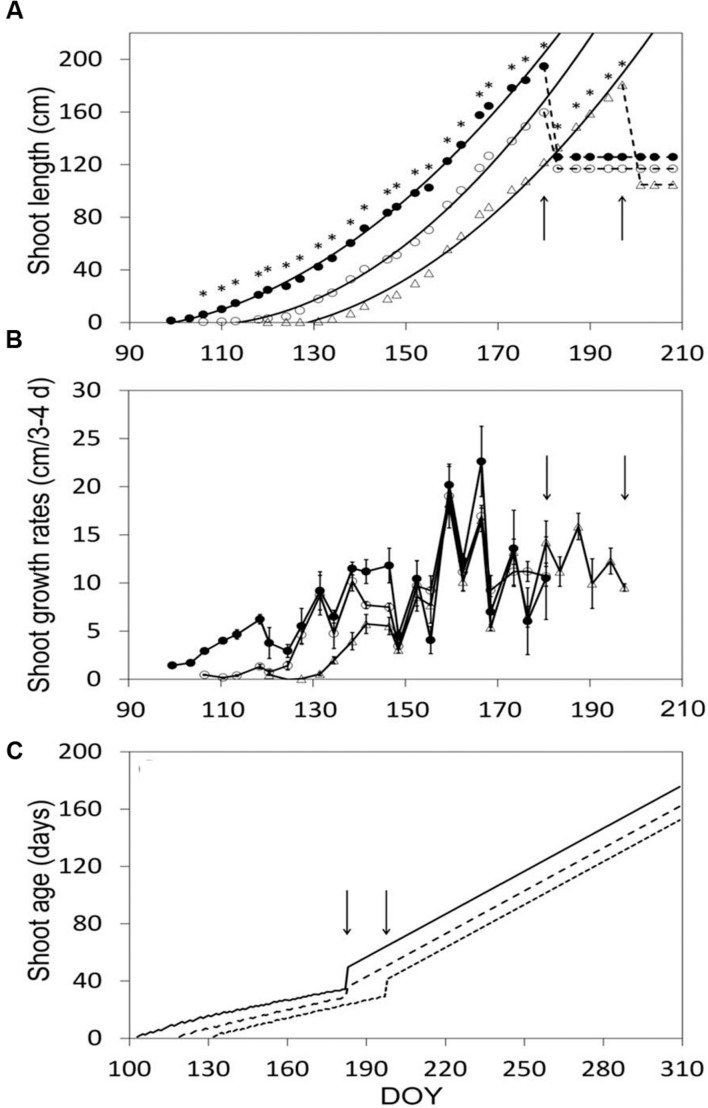
Shoot elongation (cm, A), shoot growth rates (cm/3–4 days, B) and seasonal mean shoot age (days, C) as affected by winter pruning treatments. In (A) exponential equations fit to shoot elongation vs. DOY data were: y = 0.0229x2 – 3.8597x + 157.29 (R2 = 0.996), y = 0.0301x2 – 6.292x + 326.88 (R2 = 0.995) and y = 0.026x2 – 5.6918x + 302.21 (R2 = 0.992) in SWP, LWP and VLWP treatments, respectively. In (B) vertical bars represent standard errors (SE) around means. In all panels, arrows indicate dates of shoot trimming.